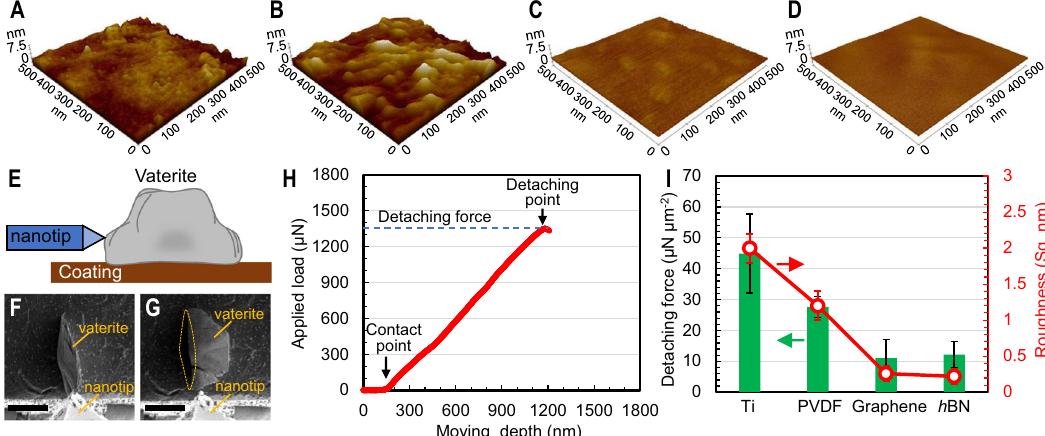
F and G represent10 µ m.Thedashedcirclein G showsthecontactareabetweenthe vaterite crystal and the underlying sample surface after detachment; H Applied forceloadincreases linearlywith the moving depthof thenanotip upon contactto thevateritecrystal; I Theaveragevateritedetachingforceandsurfaceroughnessof the four nanocoatings. Error bars represent the standard deviation of corre- sponding